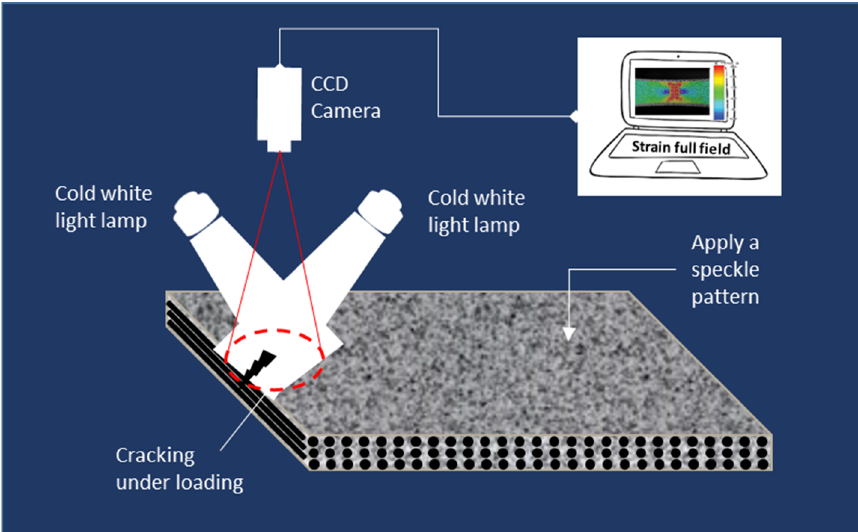
Figure 5. Principle of digital image correlation.